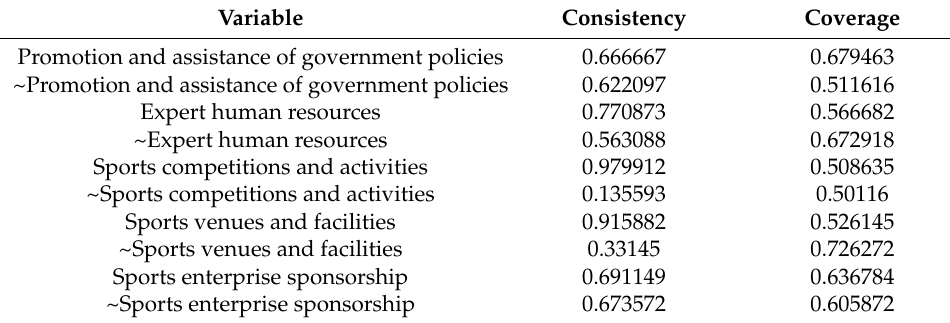
Table 3. An examination of the need for the long-term growth of sports-consuming